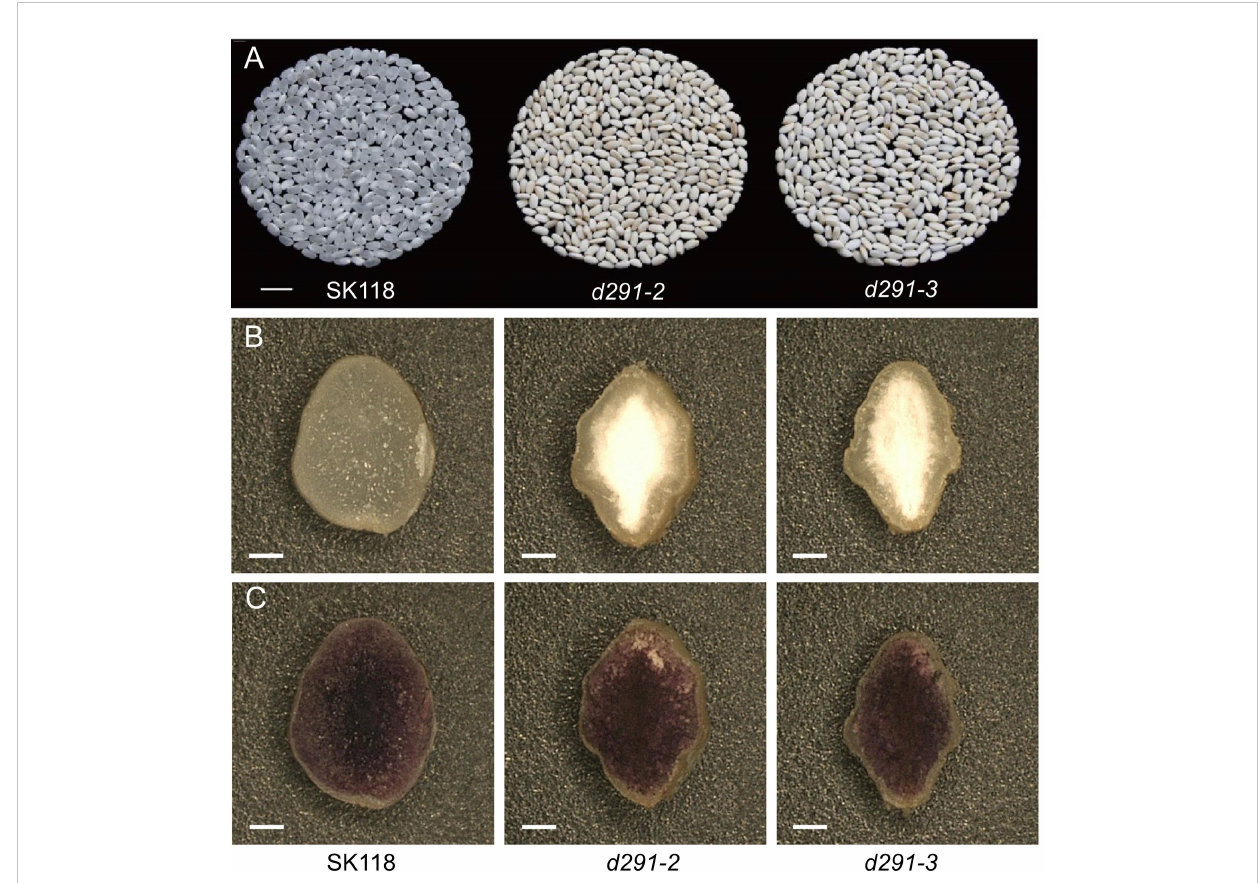
FIGURE 5 Appearance phenotype analysis of fl o2 mutants rice grain. (A) Appearance of polished rice from fl o2 mutant lines ( d291-2 and d291-3 ) in SK118 background. Bar = 1 cm. (B) Transverse sections of rice grains. Bar = 300 m m. (C) Rice grains stained with KI-I2. Bar = 300 m m.